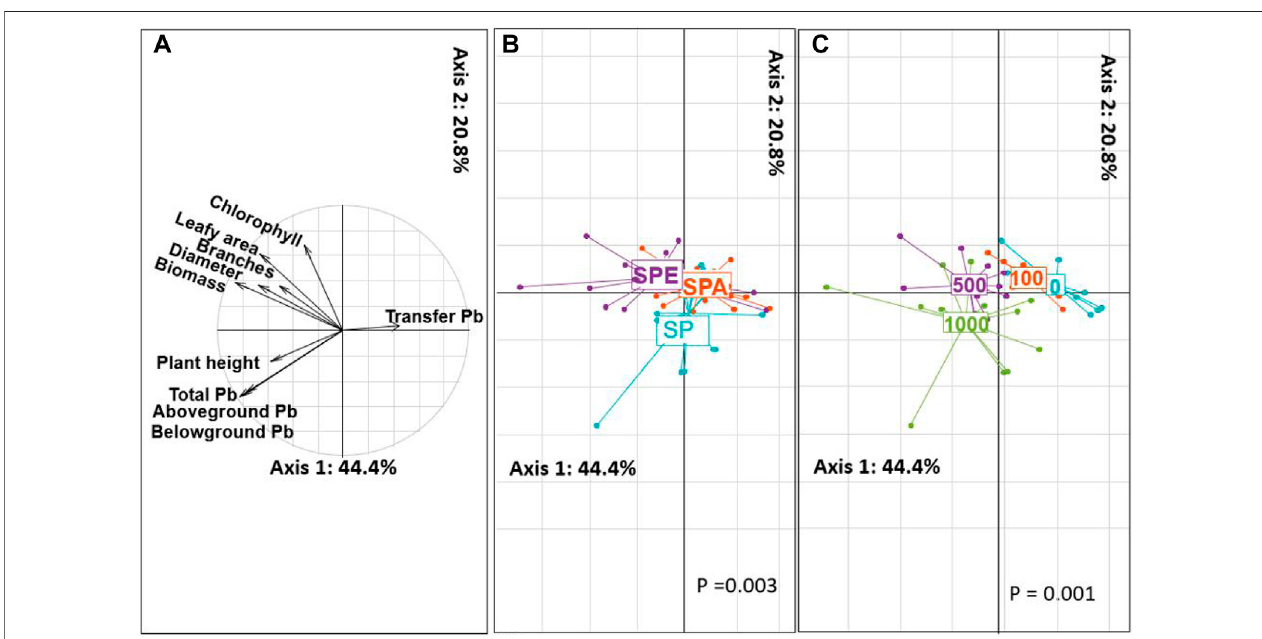
FIGURE 4 | Principal component analysis of the plant growth properties in the different treatments. (A) PCA projection of plant growth properties and Pb uptake; (B) Treatments with or without earthworms; (C) Treatments at different Pb contamination levels of 0, 100, 500, and 1,000 mg · kg -1 Pb; SP: Brassica campestris was grown, SPA: B. campestris was grown and Amynthas aspergillum was inoculated , SPE: B. campestris was grown and Eisenia fetida was inoculated.